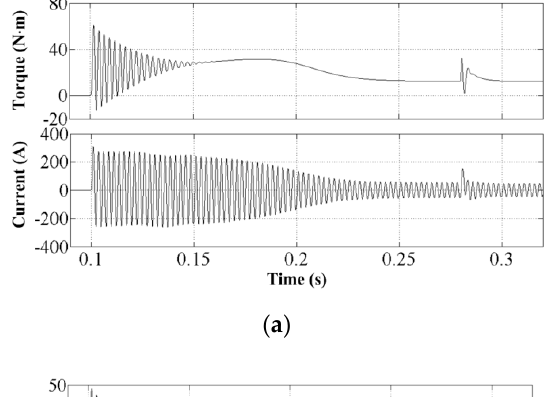
Table 4. Simulation data of starting process by different step-down methods. Table 5. Parameters of pump-type